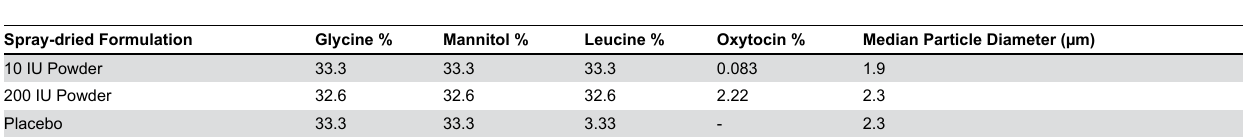
Table 1. Oxytocin ultra-fine dry powder formulation compositions and volume-based median particle diameters.